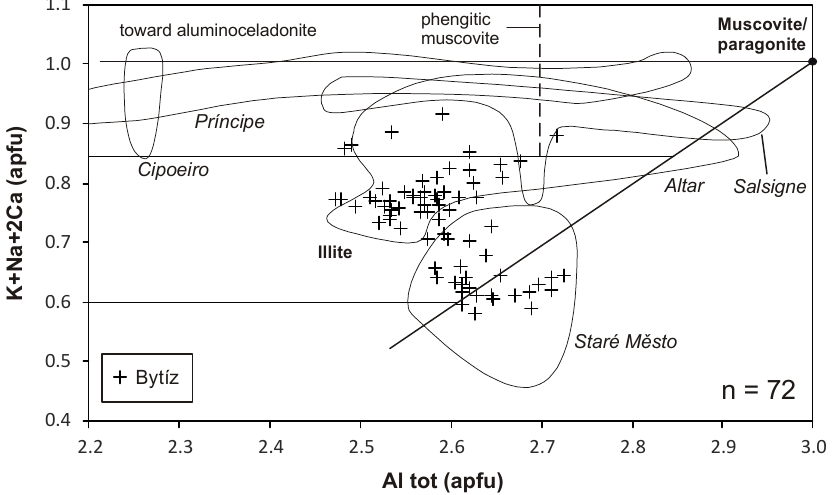
Figure 19. Chemical composition of white mica and its comparison with those of other gold depos- its. Diagram is adopted from Maydagán et al. [58], with boundaries for illite modified from Rieder et al. [59]. Note that the low amount of comparative data is caused by the lack of primary analytical data in many publications. Comparative data are from Maydagán et al. [58], de Siqueira Corrêa et al. [60], Klein et al. [61], Demange et al. [62], and Dolní č ek et al. [63].